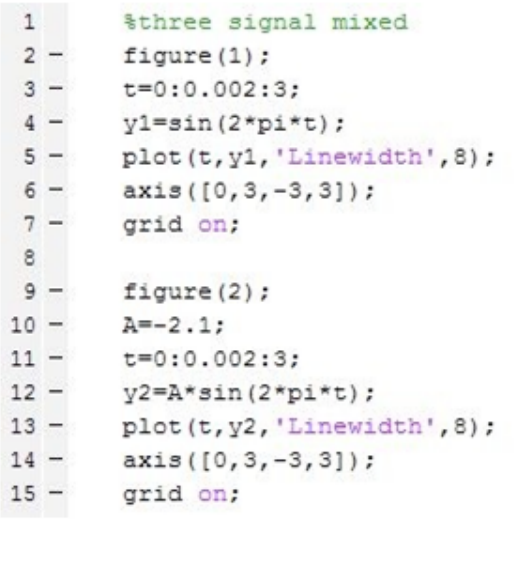
Figure 1. Define formula in Matlab